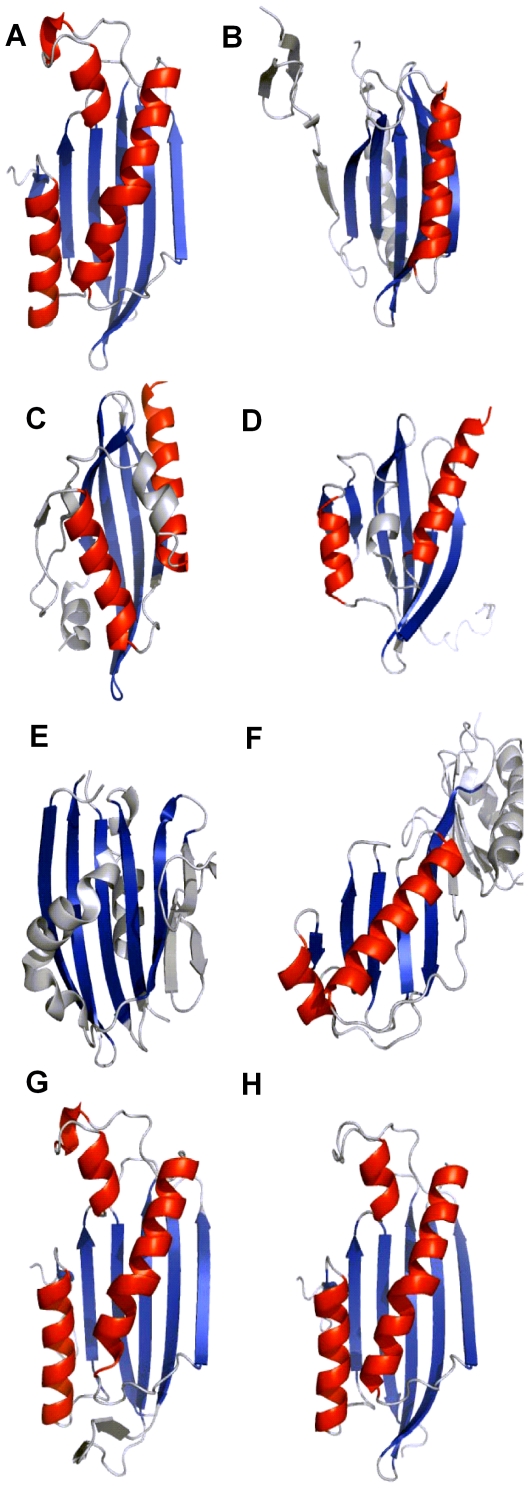
Protein structures that share some similarity to Yer067w according to DALI and SSM searches.The partially aligned β-strands and α-helices are shown in blue and red, respectively. Insertions are shown in gray. Note that most of the superimpositions are driven by the β-strands. Protein description and homology scores are as follows: (A)11V-161NYer067w structure, PDB: 3bcy; (B) Unknown function protein PA94 from Pseudomonas aeruginosa, PDB: 1tu1, Z score: 5.9, Q score: 0.17; (C) NTF-like Bal32a from a Soil-Derived Mobile Gene Cassette, PDB: 1tuh, Z score: 3.2, Q score: 0.12; (D) NTF2-like protein of unknown function from Burkholderia xenovorans, PDB: 3en8, Z score: 4.3, Q score: 0.16, (E) PsbP protein in the Oxygen-Evolving Complex of Photosystem II from higher plants, PDB: 1v2b, Z score: 5.7, Q score: 0.11; (F) Adenovirus major late promoter TATA box-binding protein, PDB: 1qna, Z score: 1.8, Qscore: 0.041. For comparison, molecular modeling structures of Yer067w homologs are also shown: (G) DEHA0D4532 model, Z score: 26.2, Q score: 0.87. (H) Yil057c model, Z score: 28.5, Q score: 1.